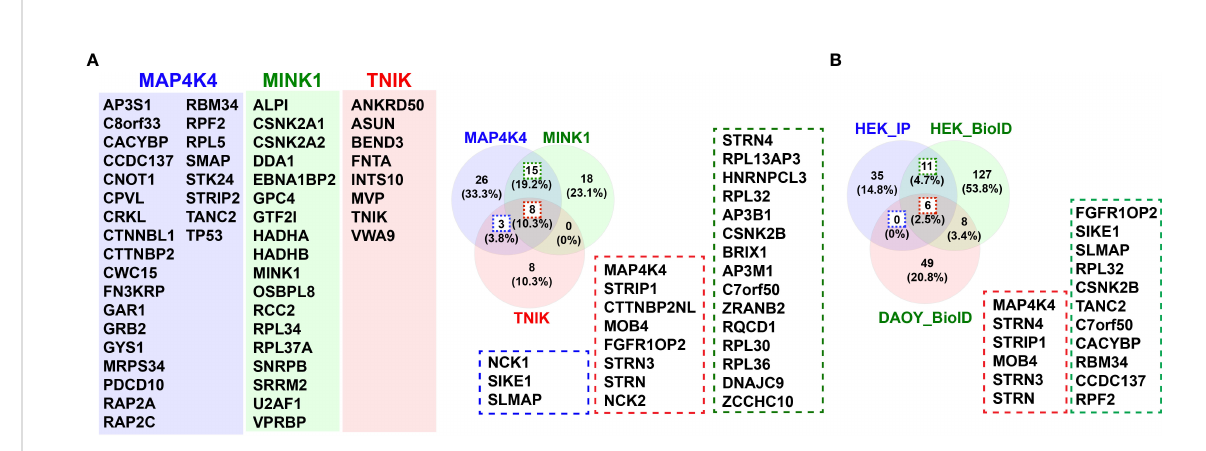
FIGURE 4 Interactors of MAP4K4. (A) Venn diagram of comparison of interactors of MAP4K4, MINK1 and TNIK identi fi ed by tandem af fi nity puri fi cation (5). 26 of the 52 proteins identi fi ed in the MAP4K4 pull-down were unique to MAP4K4, 15 also found in the MINK1 pull-down (green dotted line) and 3 found in the TNIK pull-down (blue dotted line). 8 of the proteins identi fi ed in the MAP4K4 pull-down were found both in the MINK1 and the TNIK pull-down (red dotted line). (B) Venn diagram of comparison of MAP4K4-associated interactors of MAP4K4, identi fi ed by tandem af fi nity puri fi cation (5) and proteins identi fi ed by proximity ligation (62). 11 (17%) of the proteins were detected in HEK293T cells both by pull-down and proximity ligation (green and red dotted lines). 6 proteins were detected both in HEK293T and DAOY cells (red dotted line), 8 proteins were detected